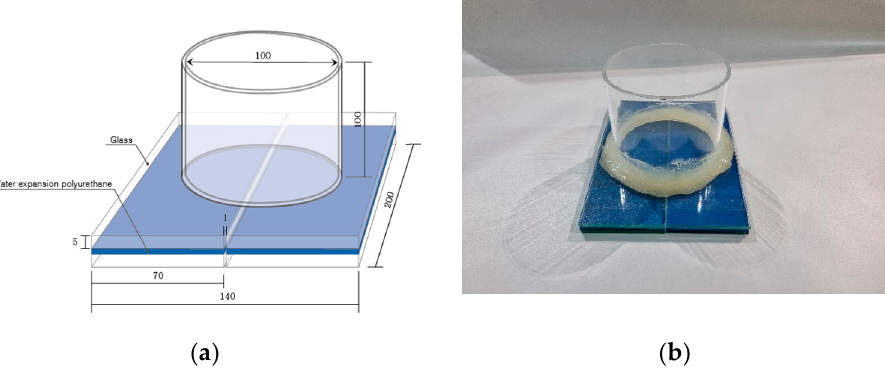
Figure 8. The fabrication process of specimens for the waterproofing performance evaluation: ( a ) Specimen concept map; ( b ) Completed specimen.